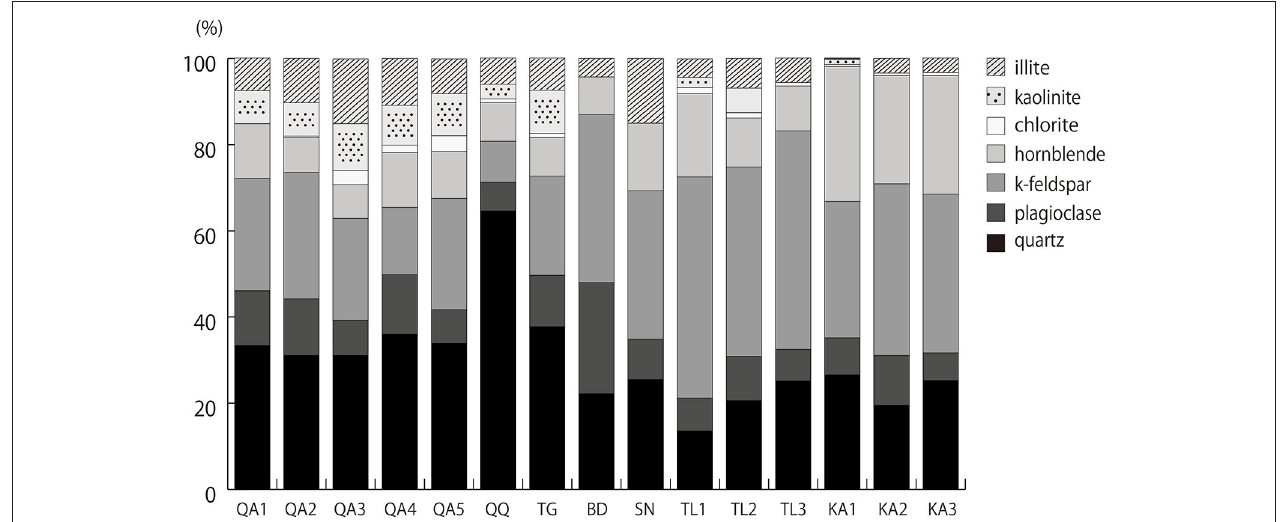
FIGURE 4 | Silicate mineral compositions of cryoconites on glaciers in northwestern and southwestern